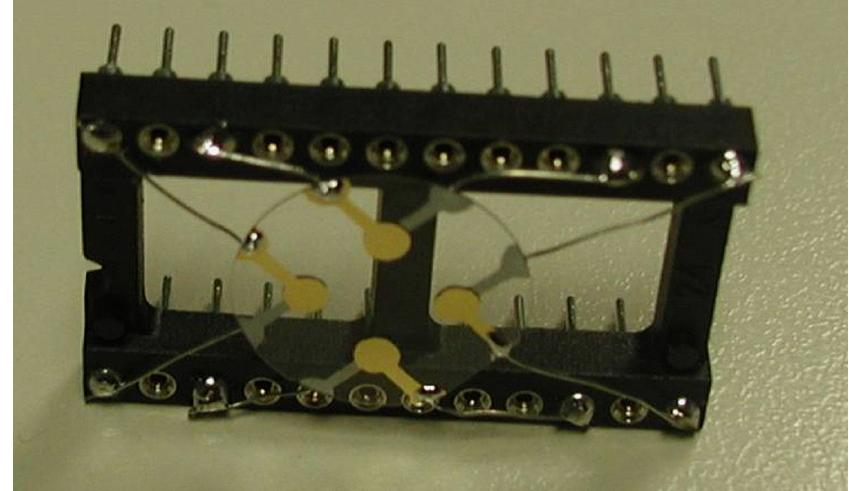
Figure 1. The prototype of a MQCM layed on a single quartz plate used for the electrical